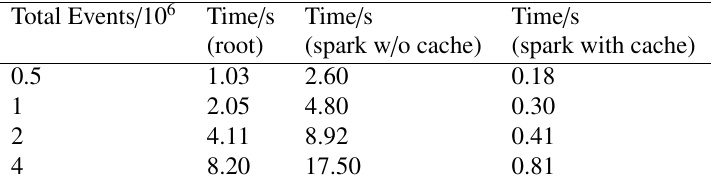
Figure 5. The example of measured performance in the test-bed Table 1. Measured time of the